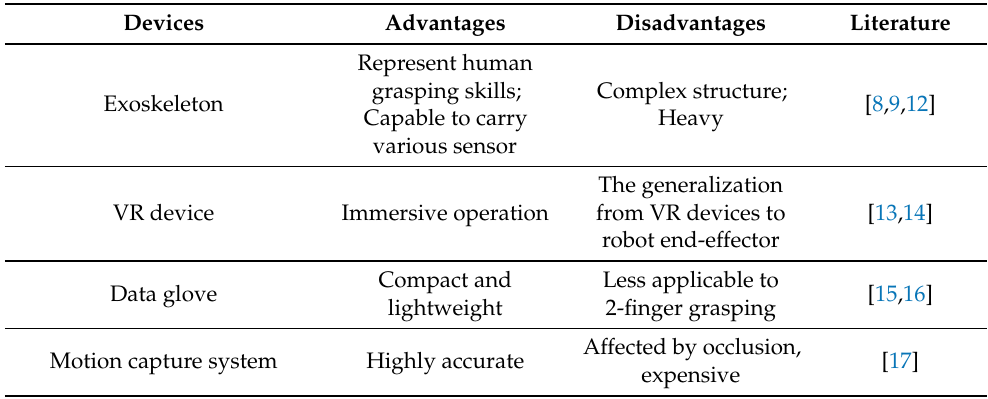
Table 1. Review of devices for hand motion